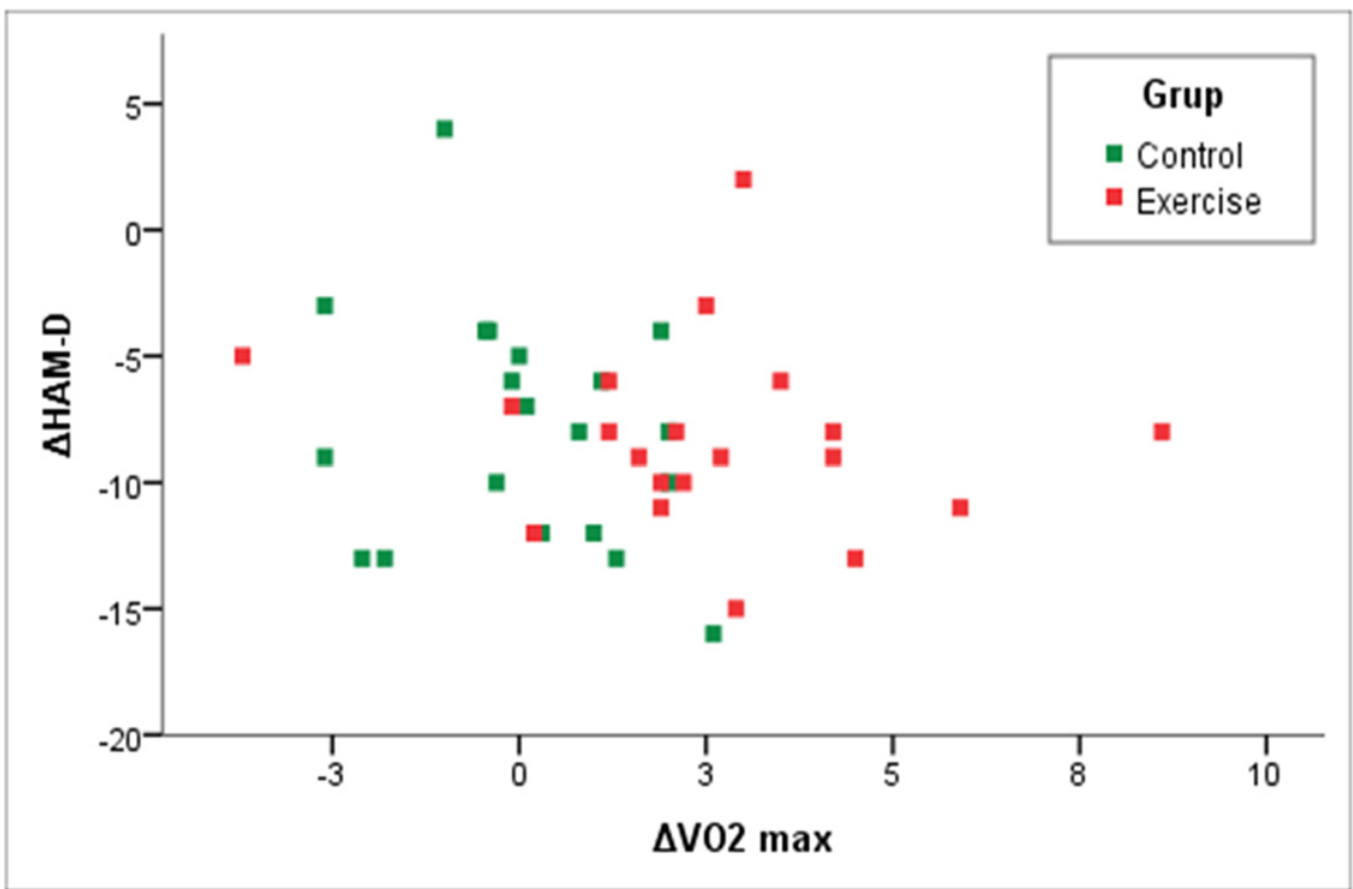
Fig 3. Correlation between changes in HAM-D score and VO 2 max from baseline to endpoint.